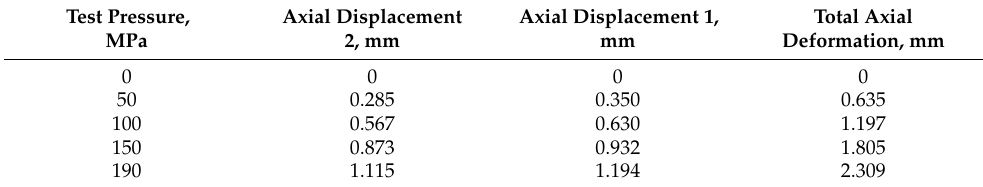
Figure 13. Axial deformation of the drill pipe cabin. According to Figure 13, when the internal pressure of the drill pipe chamber rises, the axial deformation detected at both ends of the drill pipe cabin presents a linear in- crease trend with the increase of pressure, indicating that the drill pipe cabin was always in the elastic deformation stage under the pressure condition of 0 MPa to 190 MPa, and can operate safely and stably. Furthermore, it is found that the deformation data of the two detectors are close to each other, which indicates that the deformation of one end is half of the total axial deformation of the drill pipe cabin, as long as their structure is con- sistent, even if the length of the two drill pipe cabins is not consistent. Meanwhile, under the condition of maximum pressure of 190 MPa, the maximum deformation of the drill pipe cabin is 2.309 mm, and the relative deformation is 0.046%, which is greatly reduced compared with that of rock sample chamber, which is 0.291%. It is further explained that, in the calculation of the wall thickness of the drill pipe cabin in Section 3.1.3 of this paper,